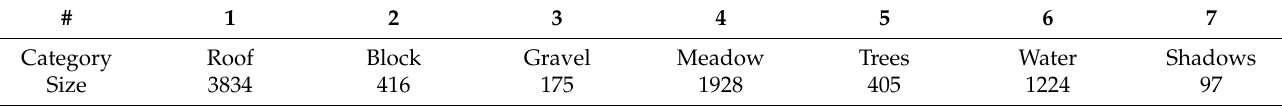
Table 3. Land category and sample size of Washington DC Mall data